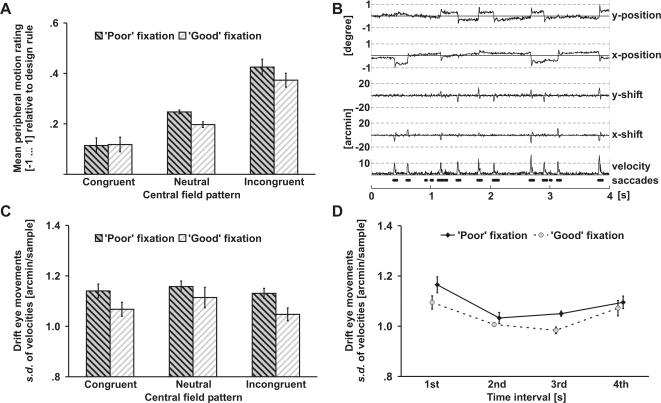
Role of eye movements (Exp. 2).A) Perceived peripheral motion varied with central patterns in both fixation conditions. The central pattern had a stronger effect in ‘poor’ (blank circle) than in ‘good’ (cross) fixation trials. B) Representative eye trajectory during pattern presentation. Four seconds (250 Hz sampling rate) of eye movements (horizontal and vertical) following pattern onset are shown. Horizontal (x) and vertical (y) eye positions were converted into instantaneous velocity vectors (shifts between two samples) and filtered by a 20 ms unweighted box-car filter. Subsequently, velocity vectors were transformed into polar vectors (direction and amplitude). Saccade periods (bold) were detected as described elsewhere [22] (see also Materials and Methods). C) ‘Poor’ fixation resulted in larger fixation instability (s.d. of instantaneous velocities of saccade-free drift periods) than ‘good’ fixation. Pattern arrangement (incongruent, neutral, and congruent) had no effect on eye movements. D) Time course of drift micromovements (fixation instability). Fixation instability was calculated for each of four consecutive time intervals (each one second) starting with pattern onset. Drift micromovements decreased between the 1st and 2nd and increased between the 3rd and 4th interval. Error bars reflect within-subjects standard errors of the mean.